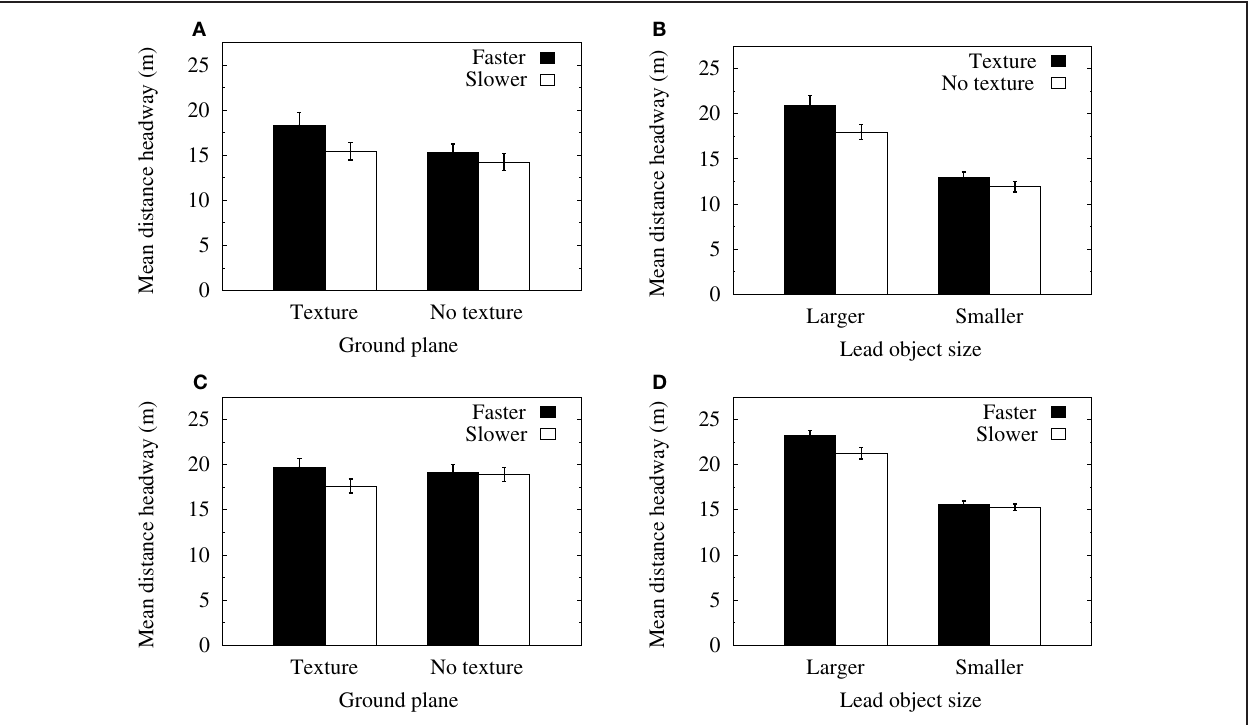
FIGURE 3 | (A) Mean distance headways in the velocity-control condition as a function of the speed of the lead object and the presence of ground texture. (B) Mean distance headways in the velocity-control condition as a function of the size of the lead object and the presence of ground texture. (C) Mean distance headways in the